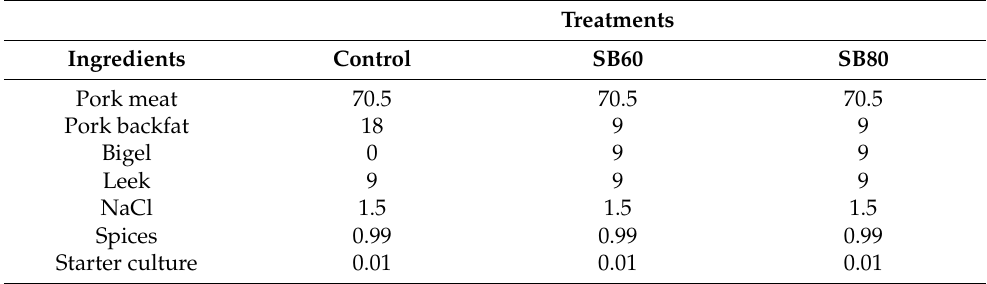
Table 2. Composition (g/100 g of meat mixture) of the different fermented sausage